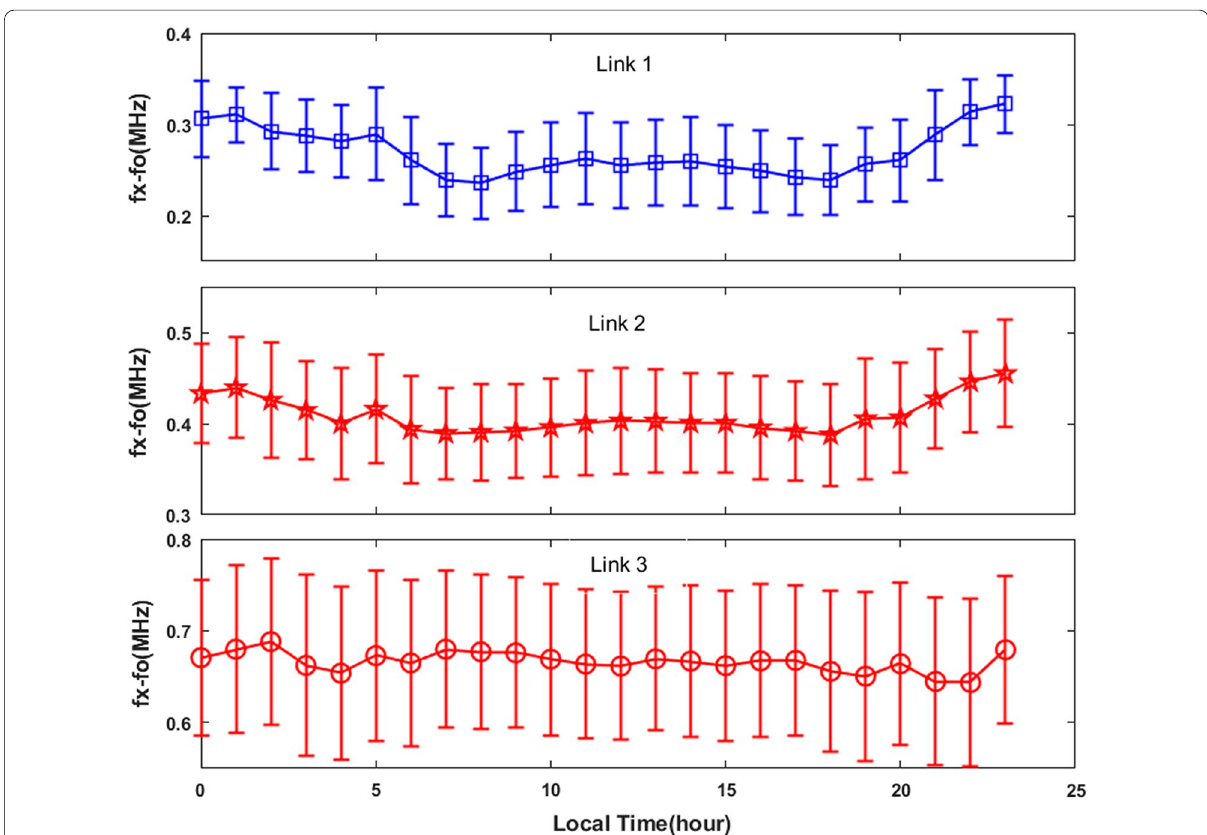
Fig. 4 Local time variation of the separations observed through three radio